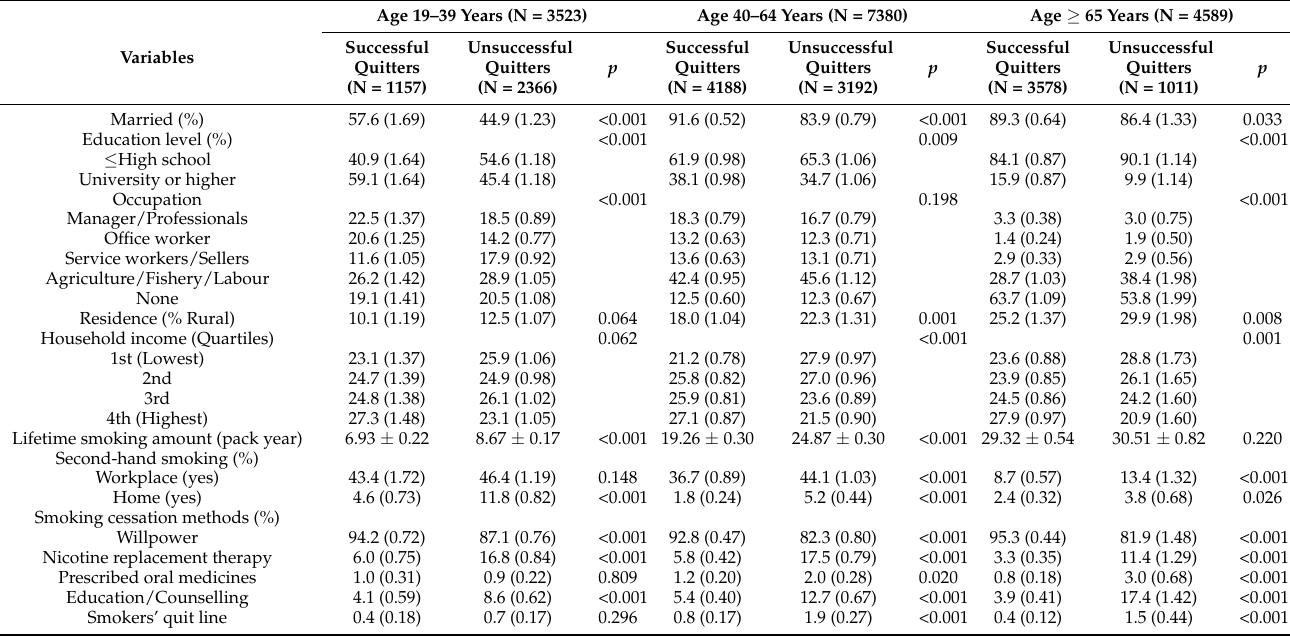
Table 2. Sociodemographic characteristics and smoking history of study participants by age group (N = 15,492).